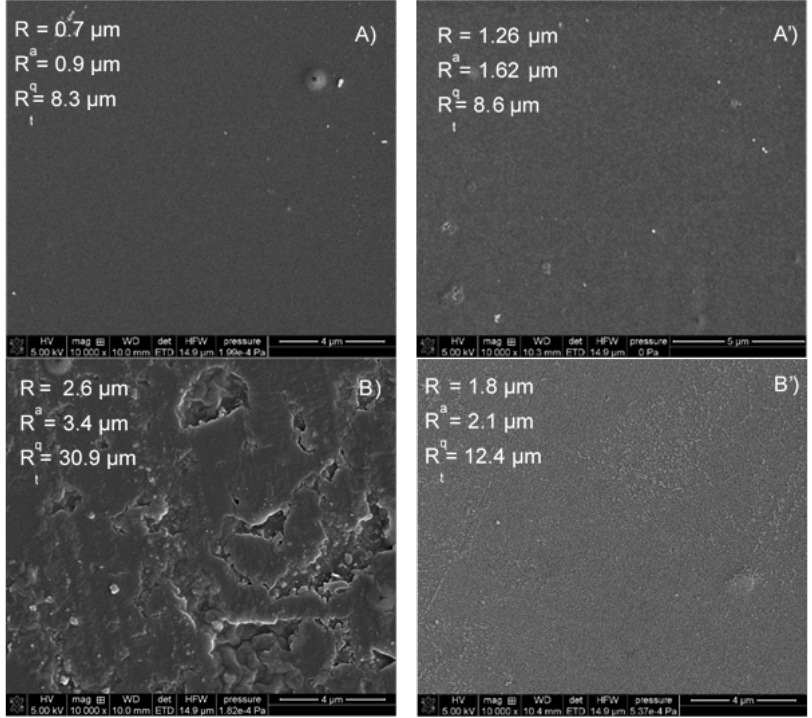
Figure 1. SEM images of chitosan foils: ( A ) sample 1; ( A’ ) sample 1 treated with N 2 plasma; ( B ) sample 2; ( B’ ) sample 2 treated with N 2 plasma.